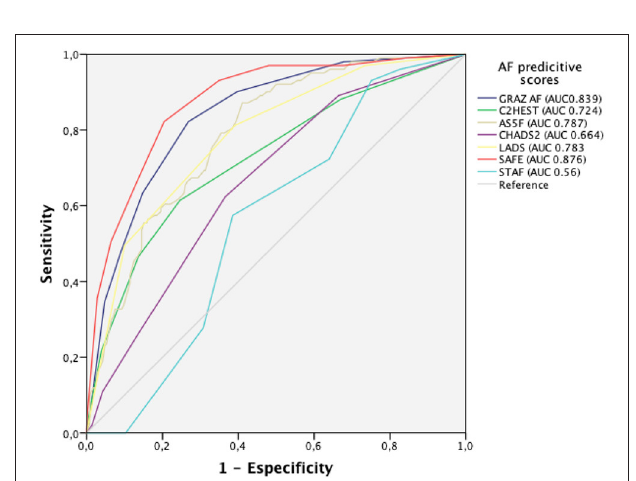
FIGURE 4 | Prediction of atrial fibrillation by SAFE compared to other predictive scores. SAFE showed an AUC of 0.876 (95% CI 0.838–0.913, p < 0.001). The AUC of GRAZ AF was 0.839 (95% CI 0.797–0.881); AUC of C2HEST 0.724 (95% CI 0.665–0.783), AUC of AS5F was 0.787 (95%